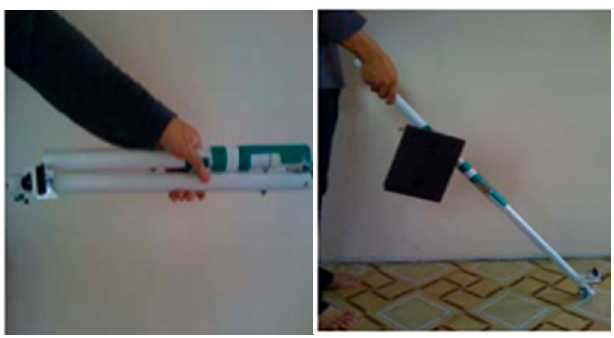
Figure 2. The Smart Cane prototype [19].